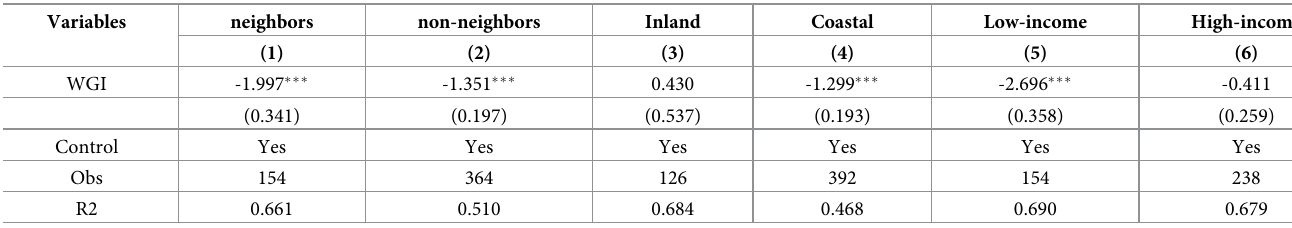
Table 7. Heterogeneity estimation